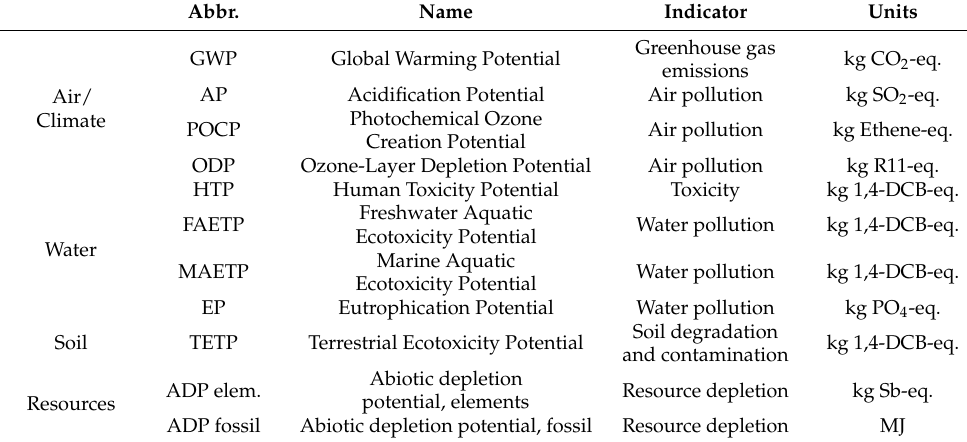
Table 5. CML2001 environmental impact indicators